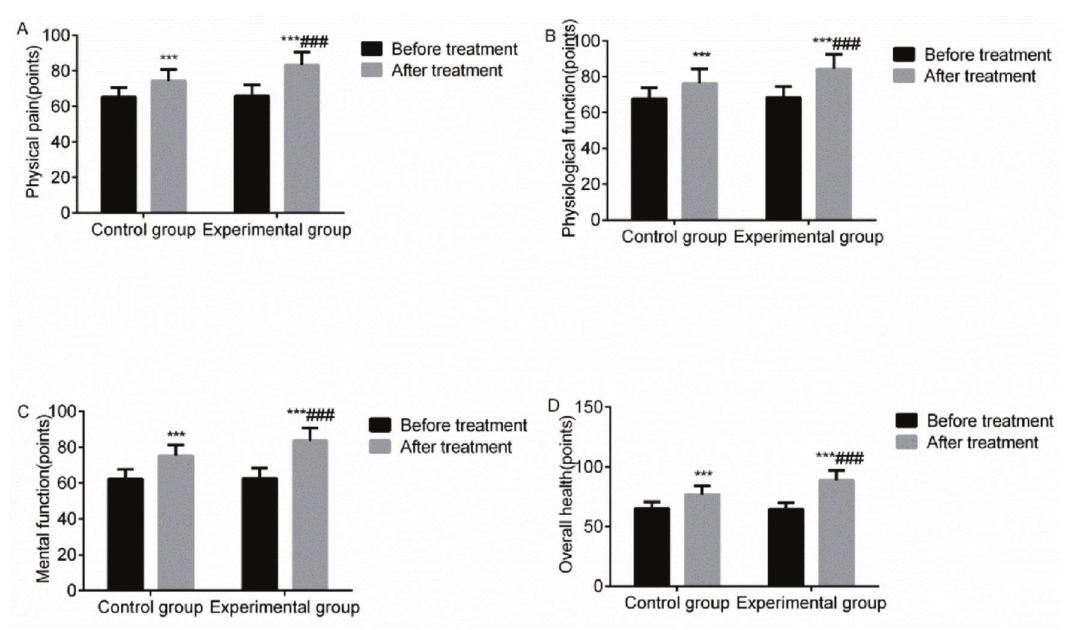
Figure 5 - Comparison of the quality of life between the two groups before and after treatment. Note: compared with the group before treatment, *** p o 0.001; compared with the control group, ### p o